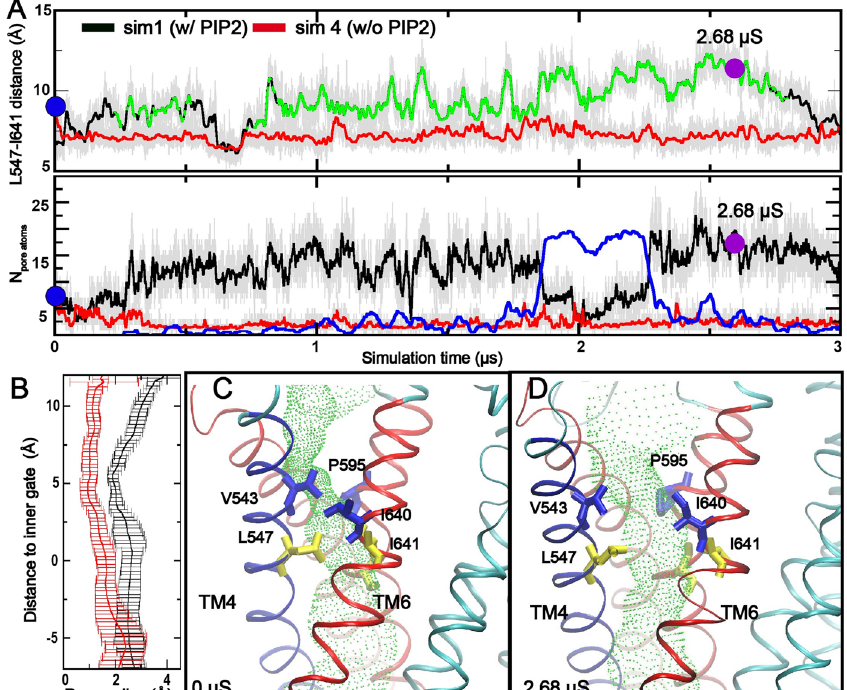
Fig. 2 Spontaneous TMEM16A pore opening induced by speci fi c PIP 2 binding. A Distance between the centers of mass of L547 and I641 (upper panel) and number of water molecules (lower panel) in the neck region as a function of simulation time. The black and red traces were derived from simulations with ( sim 1, chain B ) and without ( sim 4, chain B ) PIP 2 , respectively. In the upper panel, snapshots belonging to the open cluster (see Fig. S3) are highlighted in green. In the lower panel: the number of lipid heavy atoms inside the neck region during sim 1 is also shown (blue trace). B Averaged pore radius pro fi les in the neck region calculated using HOLE 39 . The black trace was derived from snapshots sampled during 2.679 – 2.683 μ s of sim 1 and the red trace from those sampled during 0.0 – 0.01 μ s of sim 4 . C , D Representative structures of the closed and open pores, taken from 0 ns and 2681 ns of sim 1 , respectively. TMs 3, 5, and 6 are colored in red, TM4 in blue, and the rest of the protein in cyan. Two of the inner gate residues (L547 and I641) and key pore-lining residues above the gate (V543, I640, and P595) are represented as yellow and blue sticks, respectively. The HOLE pore pro fi les are illustrated as the green